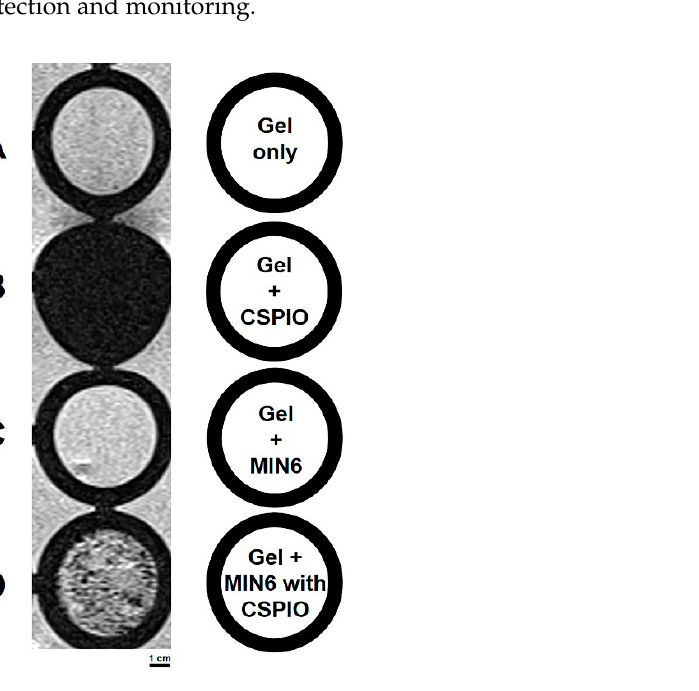
Figure 2. In vitro MRI of mPEG-poly(Ala) hydrogels, hydrogels with CSPIO nanoparticles, and MIN6 cells mixed with hydrogels after incubating with or without chitosan-coated superparamagnetic iron oxide (CSPIO) nanoparticles. All were scanned by a 7.0 T MRI system. Gel only ( A ) was used as a negative control and Gel+CSPIO ( B ) was used as a positive control. In contrast to unlabeled MIN6 cells ( C ), CSPIO-loaded MIN6 cells ( D ) appeared as dark spots.